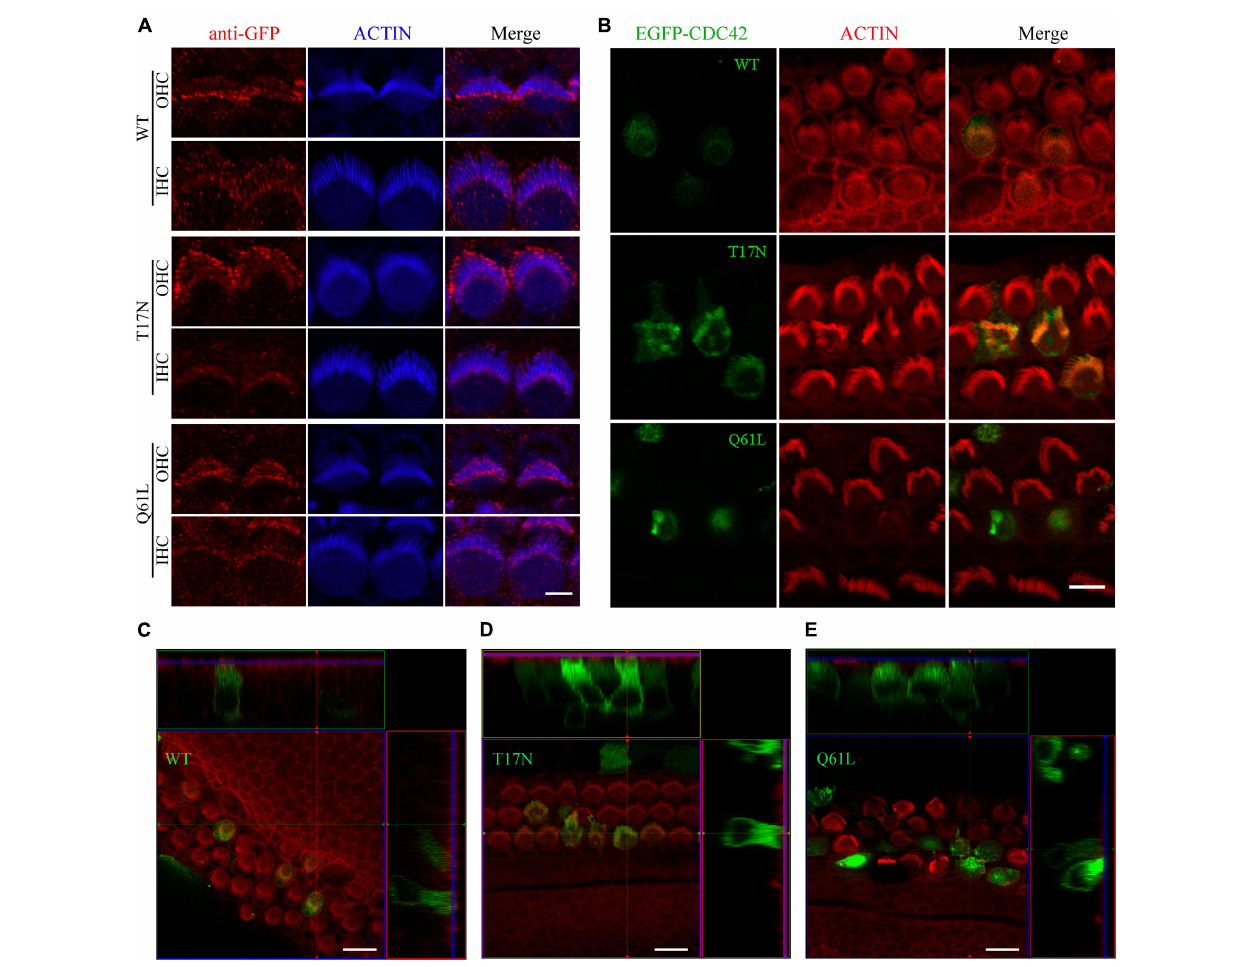
FIGURE 4 | Constitutively active CDC42 mutant leads to enhanced stereocilia deficits. (A) Whole-mount staining showing localization of purified exogenous wild-type or mutant CDC42 proteins in saponin-permeabilized P0.5 OHCs and IHCs. iFluor 405-conjugated phalloidin was used to visualize stereociliary F-actin core. GFP antibody was used to amplify the signals of EGFP fused with CDC42 proteins. Scale bar: 2 µ m. (B) Cochlear explants from P2 wild-type mice were injectoporated with expression vectors to express EGFP-tagged wild-type or mutant CDC42 in hair cells. TRITC-conjugated phalloidin was used to visualize stereociliary F-actin core. Scale bar: 5 µ m. (C–E) 3D reconstruction showing the side view of hair cells injectoporated with different CDC42 constructs as indicated. Scale bar: 10 µ